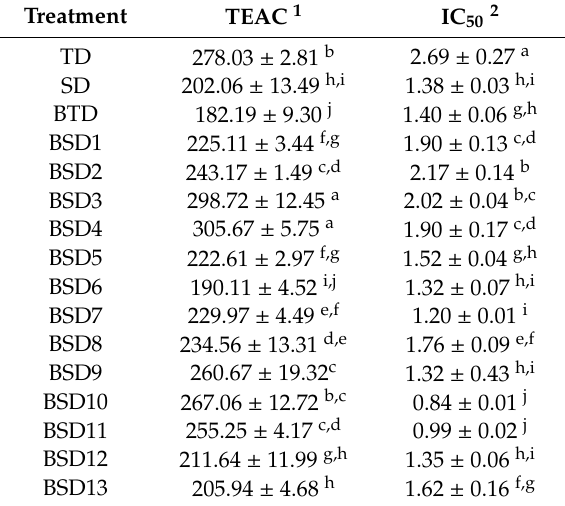
Table 2. Trolox Equivalent Antioxidant Capacity (TEAC) and Free Radical Scavenging Activity by DPPH (IC 50 ) of red dried beetroots.